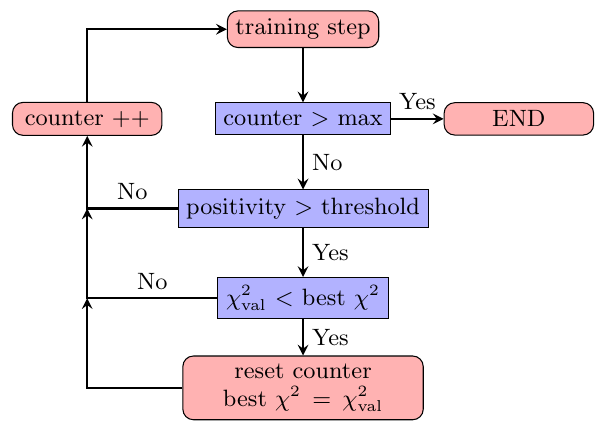
Fig. 2 Flowchart describing the patience algorithm of the n3fit code. The positivity constraint becomes more and more restrictive as the fit advances